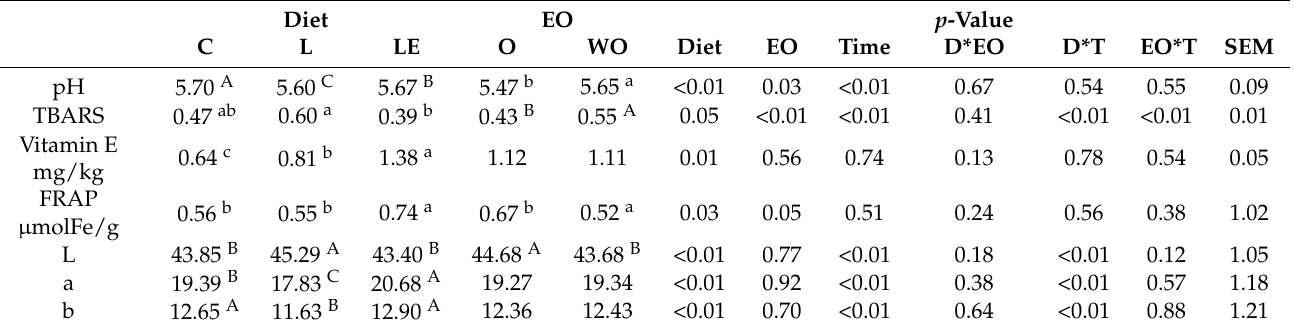
Table 3. Effects of diets (C, L and LE) and essential oils (O and WO) on Marchigiana beef burgers’ colour parameters (L, a*, b), pH, FRAP and vitamin E